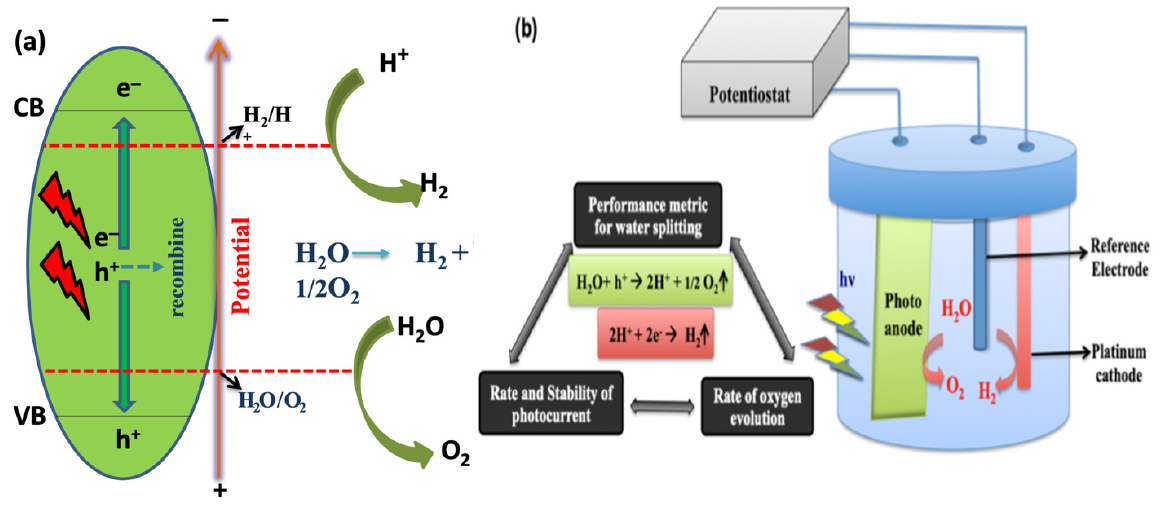
Figure 27. Schematic of ( a ) photochemical cell; ( b ) photoelectrochemical